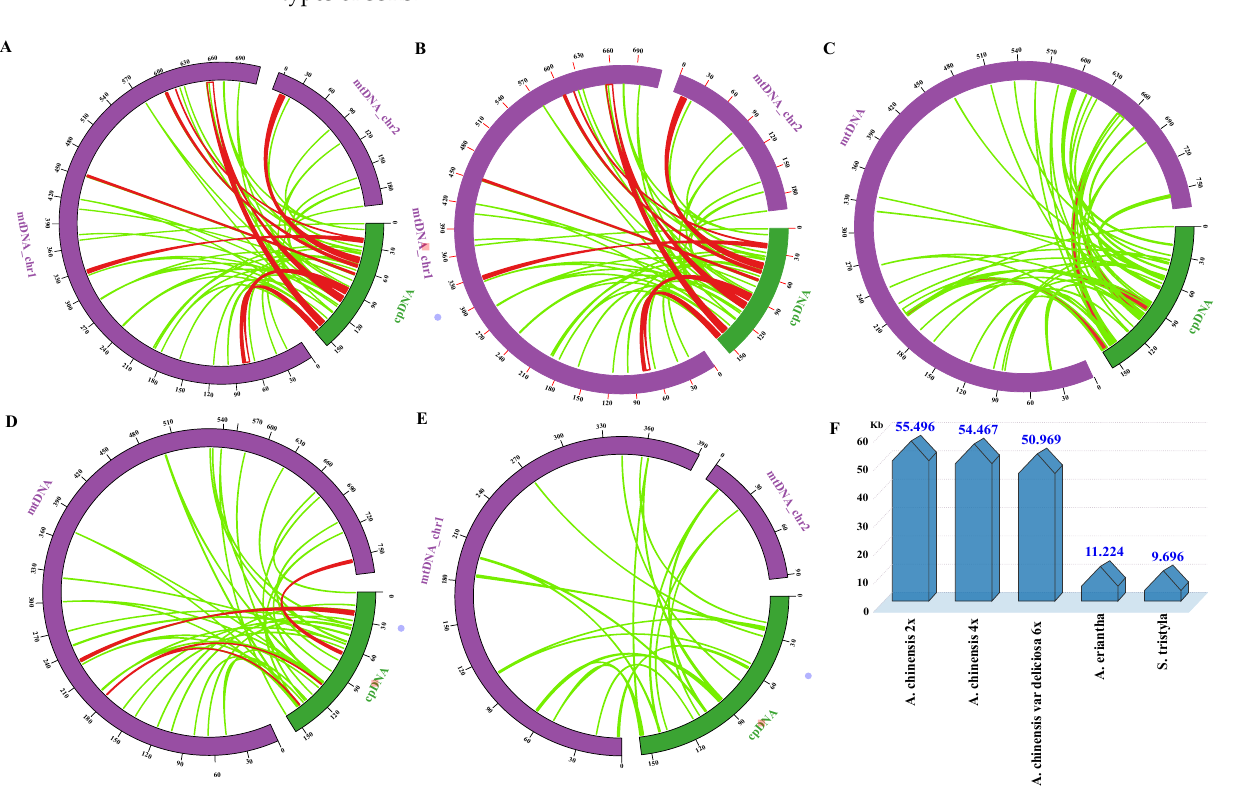
Figure 3. ( A – E ) Shared genome regions of each species between chloroplasts and mitochondria of A. chinensis (2 × ), A. chinensis (4 × ), A. chinensis var deliciosa (6 × ), A. eriantha and S. tristyla , respectively. The green circular segment represents the mitogenome, and the purple circular segment represents the chloroplast genome. ( F ) Shared sequence length of each species between chloroplasts and mitochondria